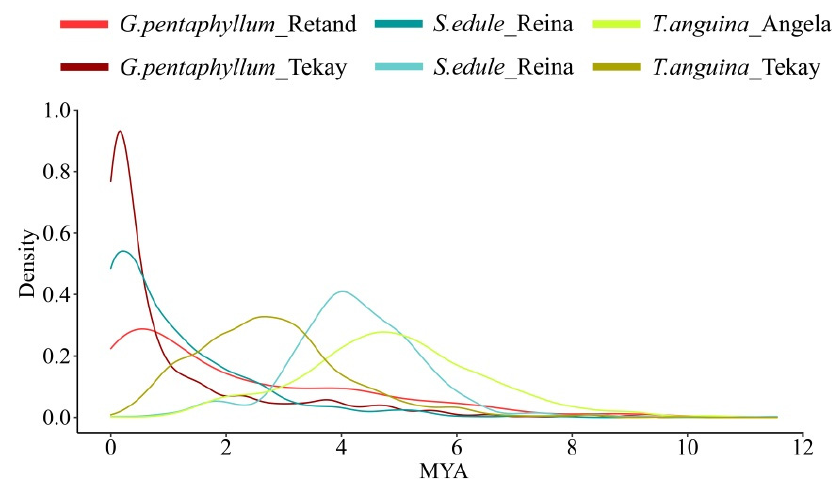
Figure 6. Insertion age of the amplified LTR-RT lineages in three species.